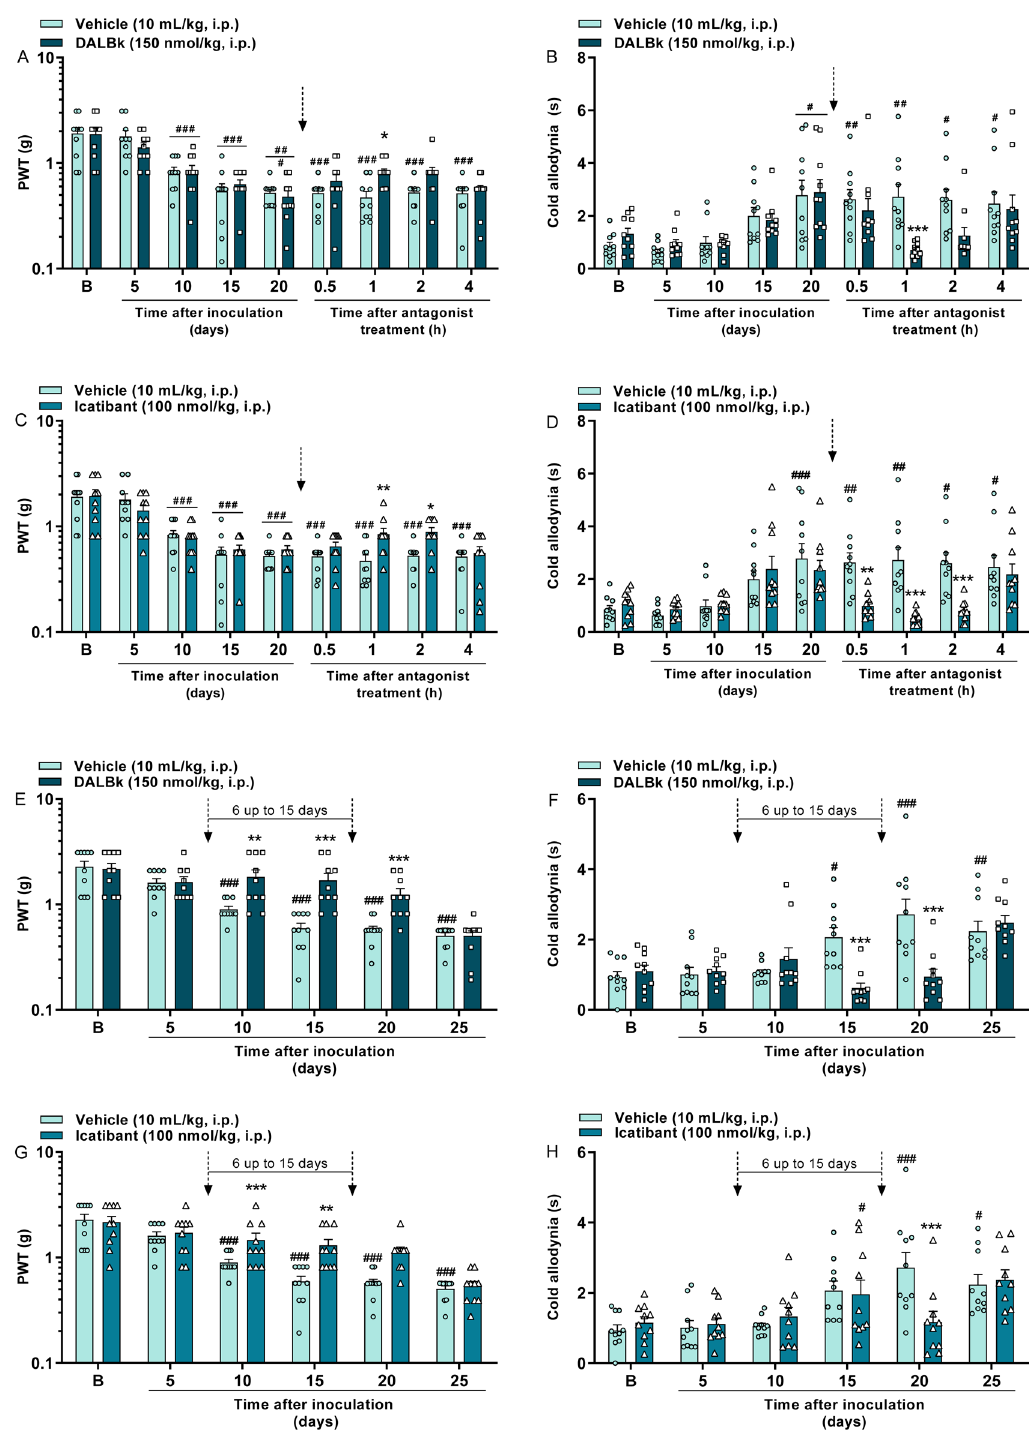
Figure 5. Kinin B 1 (DALBk, 150 nmol/kg, i.p.) or B 2 (Icatibant, 100 nmol/kg, i.p.) receptor antagonists reduce the mechanical ( A , C , E , G ) and cold ( B , D , F , H ) allodynia in breast tumor-bearing mice. Time-response curves caused by the post-treatment with the vehicle, DALBk ( A , B ) or Icatibant ( C , D ) at 20 days after 4T1 breast cancer cells (10 4 cells, 50 µL/site) injection. Early-stage repeated treatment (6–15 days) with vehicle DALBk ( E , F ) or Icatibant ( G , H ) in animals that received 4T1 breast cancer cells (10 4 cells, 50 µL/site) injection. (B) Denotes baseline mechanical threshold/nociception time before tumor induction. The dotted arrows indicate the timings of antagonist administration. Data are expressed as the mean + SEM (n = 10/group; BALB/c mice). # P < 0.05; ## P < 0.01; ### P < 0.001 when compared to the baseline (B); *P < 0.05; ** P < 0.01; ***P < 0.001 when compared to the vehicle group; two-way repeated-measures ANOVA followed by Bonferroni’s post hoc test. PWT paw withdrawal